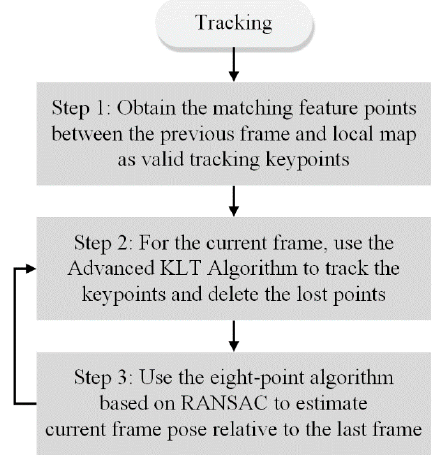
Figure 6. Flowchart of the optical-flow-based fast VO.